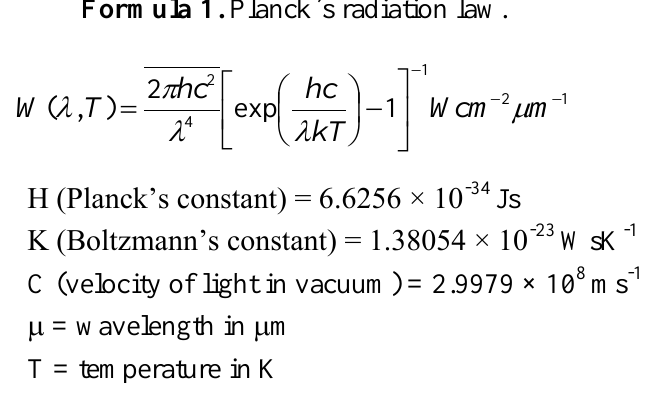
1 gives an overview of the medical imaging modalities used within the electromagnetic